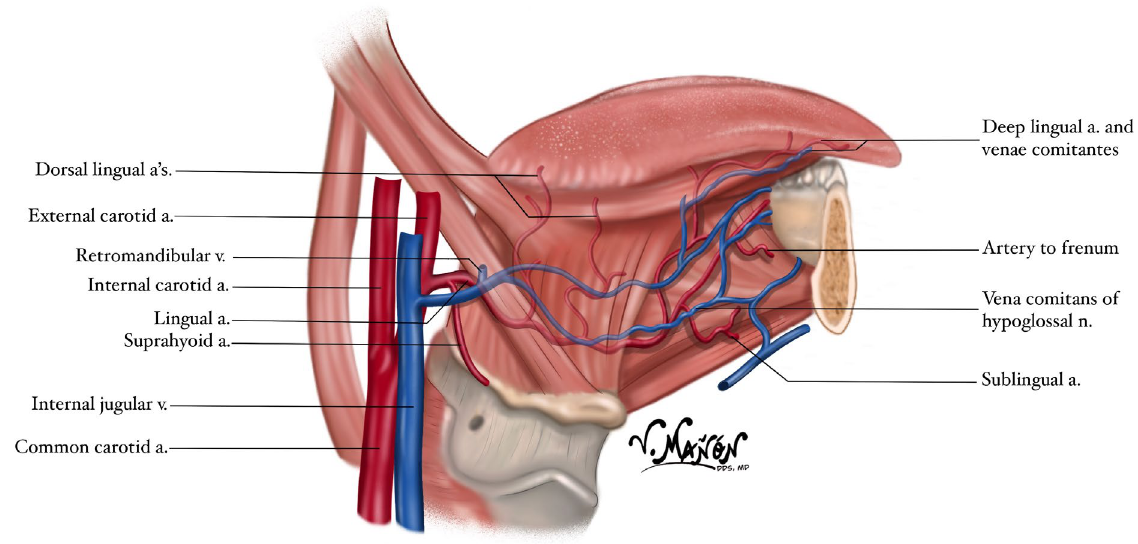
Figure 1. Course, branches, and surrounding structures of the Lingual Artery, Victoria Manon, DDS, MBA, MD.